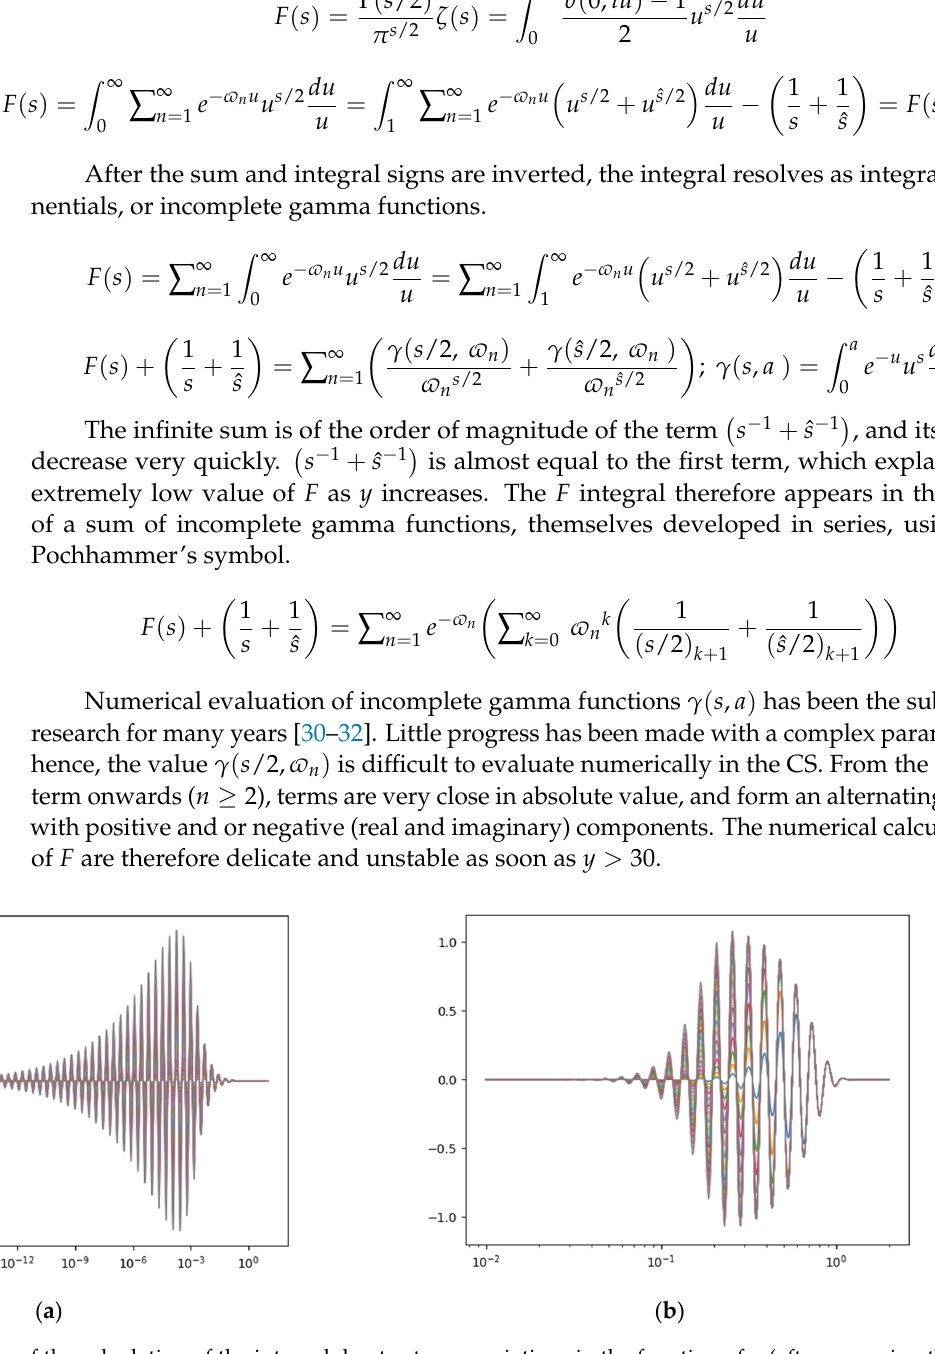
Figure 14. ( a , b ) Instability of the calculation of the integral due to strong variations in the function of u (after removing the overall influence of the exponential part) to be integrated, for the first n terms. The numerical calculation of the integral requires a very large number of samples of the value of the integrand function (around ten million between 10 − 2 and 1 ).